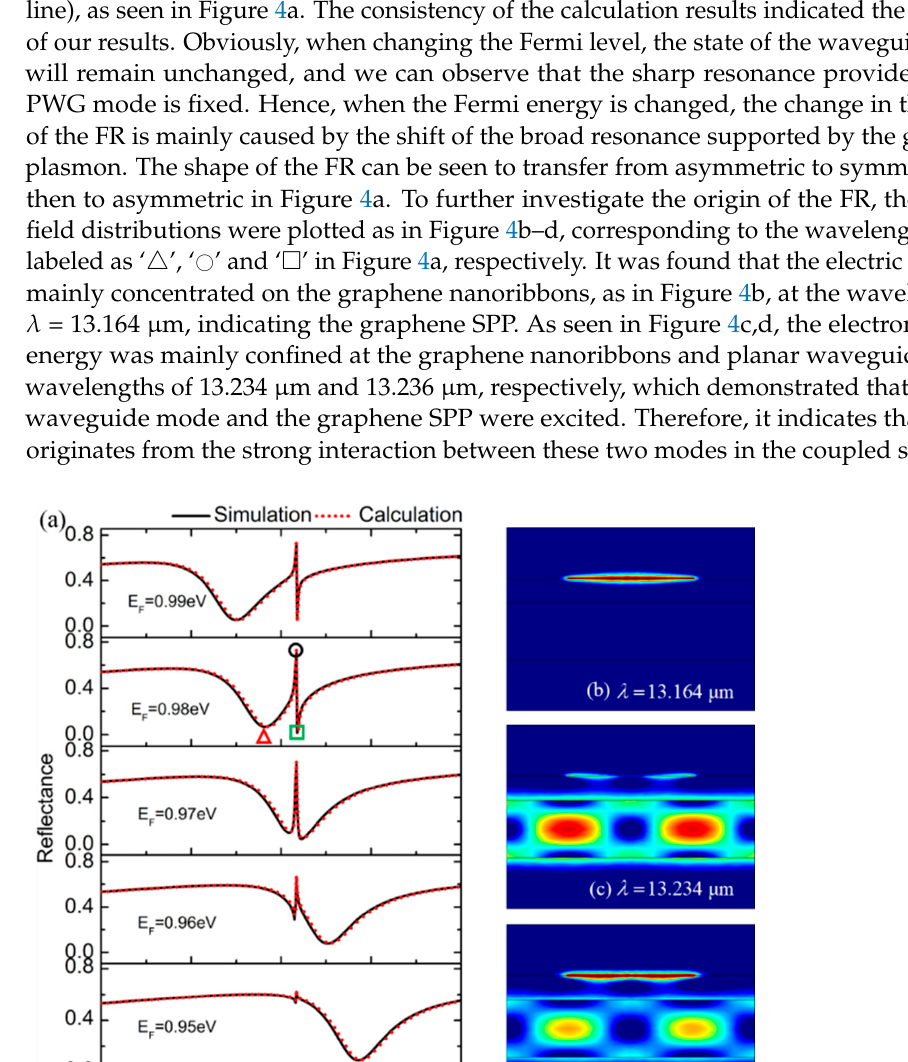
Figure 3. ( a ) The reflection spectrum of the structure when Λ changes from 3.9 to 4.1 μ m with a step size of 0.05 μ m. ( b ) The reflectance contour plot of wavelengths and Λ .